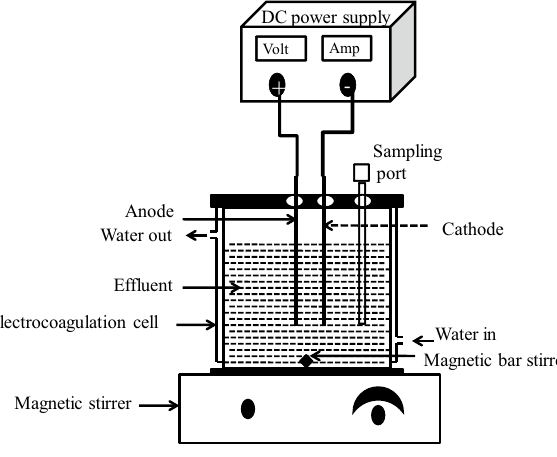
Fig. 1 Experimental setup for the electrochemical